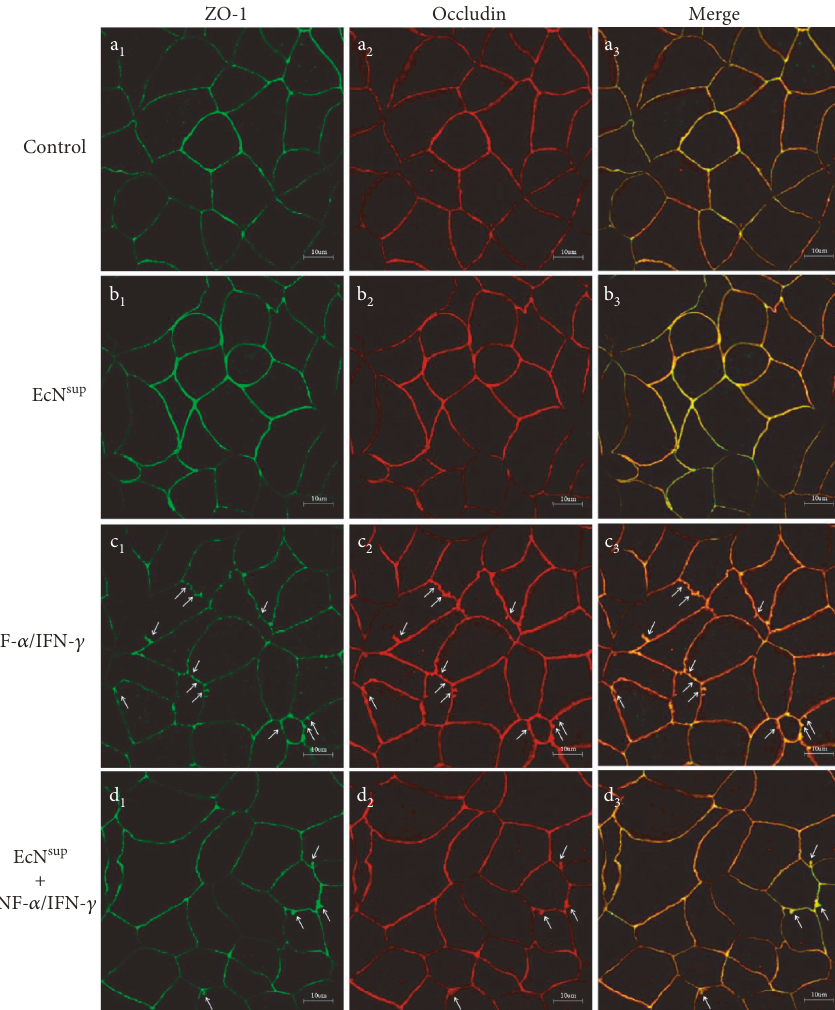
Figure 4: Immuno fl uorescence staining of Caco-2 cell monolayers grown on fi lters against ZO-1 and Occludin. (a group, Caco-2 monolayers were treated with DMEM medium without TNF- α /IFN- γ or EcN sup . (b monolayers were incubated with EcN sup for 48h. (c TNF- α and 10ng/mL IFN- γ for 48 h. (d EcN sup for 48 h in the presence of 10ng/mL TNF- α and 10 ng/mL IFN- γ . The medium containing di ff erent reagents was changed every